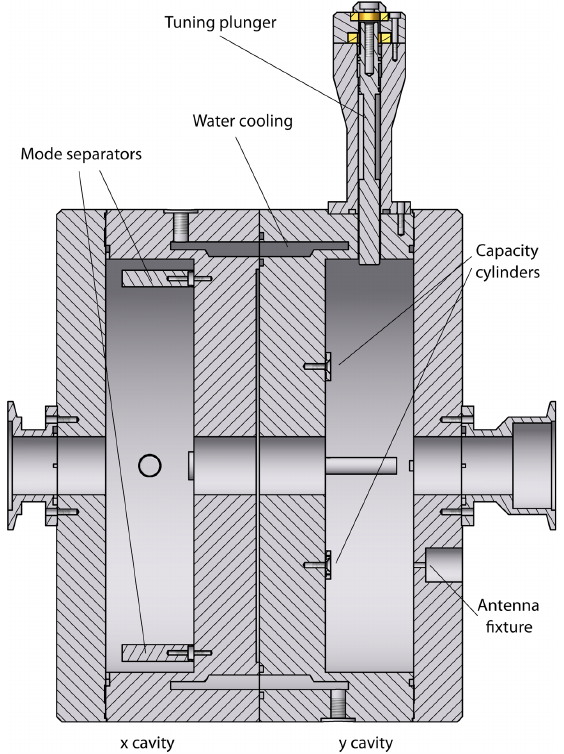
FIG. 4. A cross-section view of the resonator assembly de- signed to measure the beam position (created with AUTODESK (cid:1) INVENTOR (cid:1)